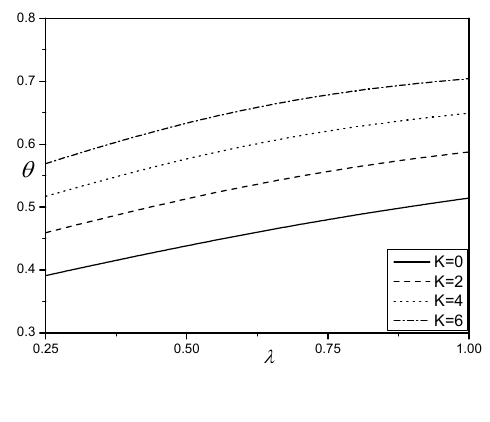
Fig. 16 Chemical reaction effect on θ ( λ )